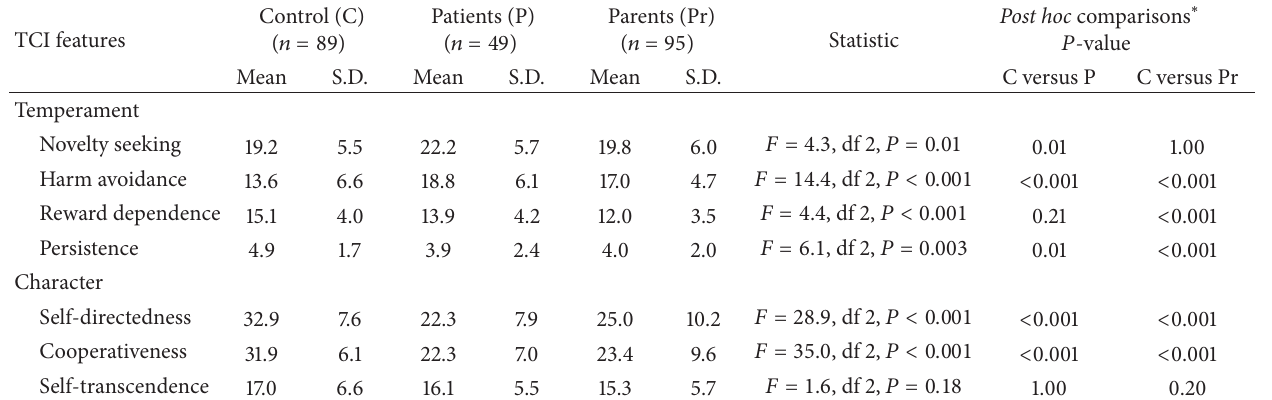
Table 2: Temperament and character dimensions among